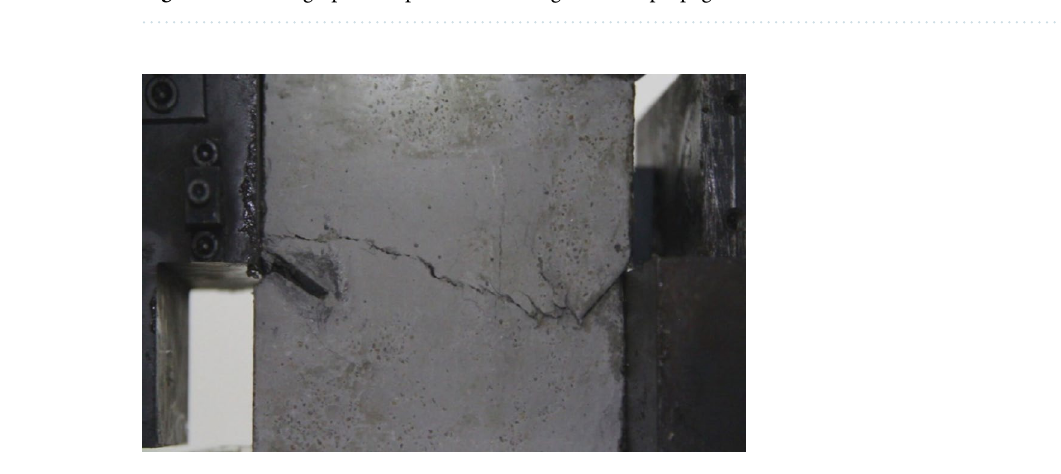
Figure 25. Photograph of a specimen showing fractures